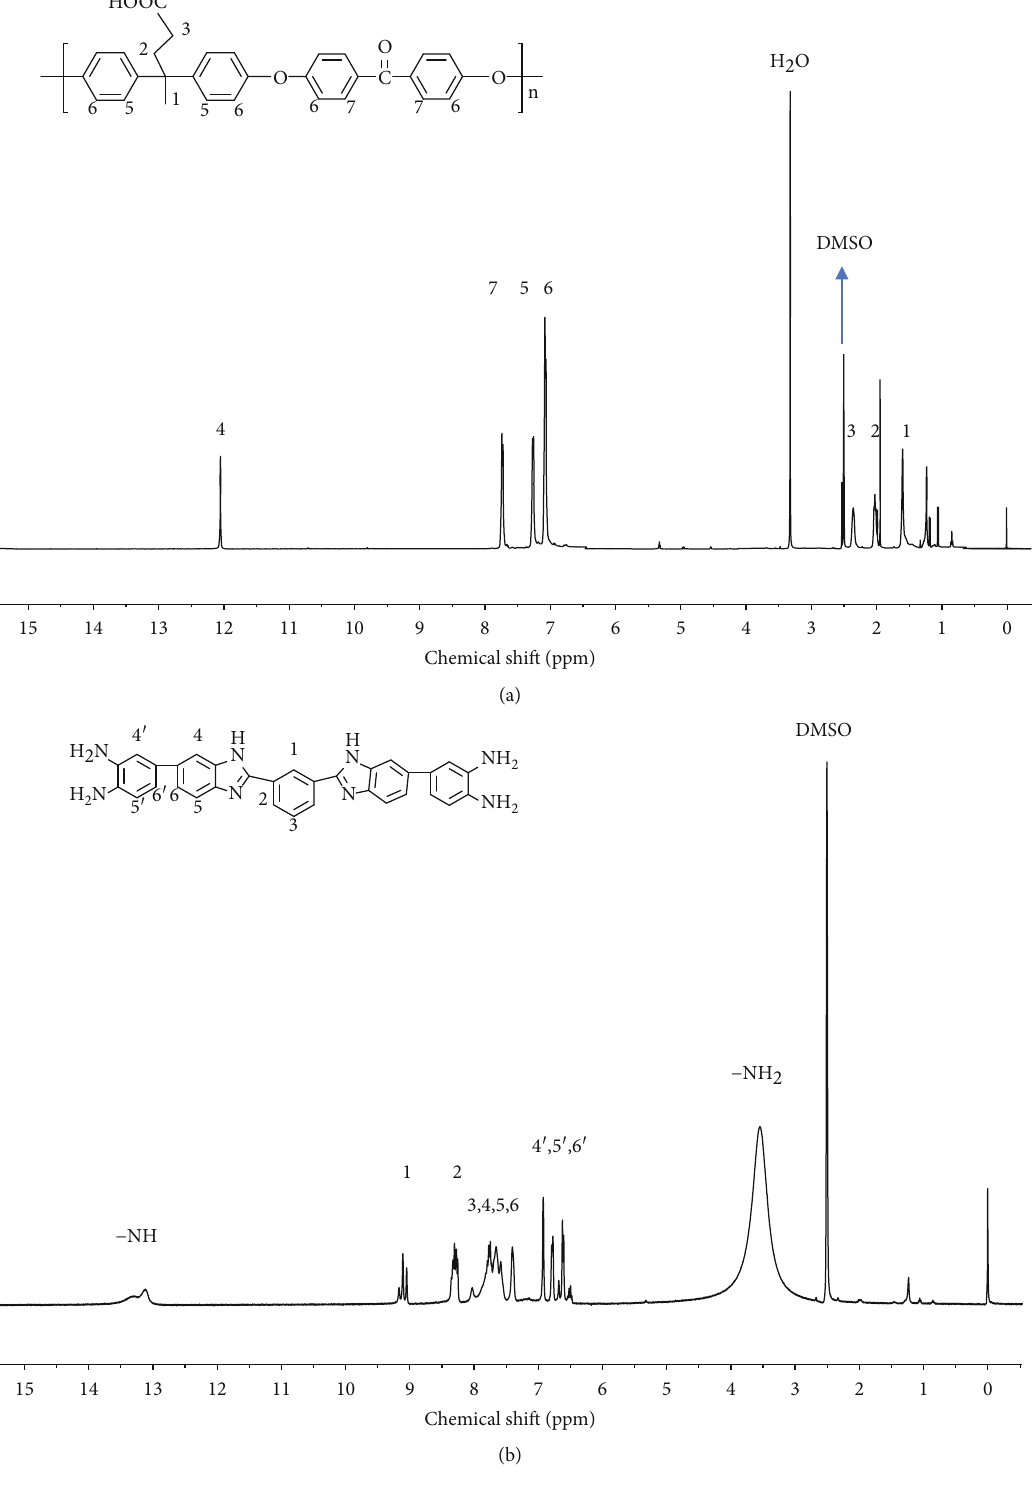
Figure 2: 1 H NMR spectra of (a) PAEK-COOH and (b) PBI-4NH